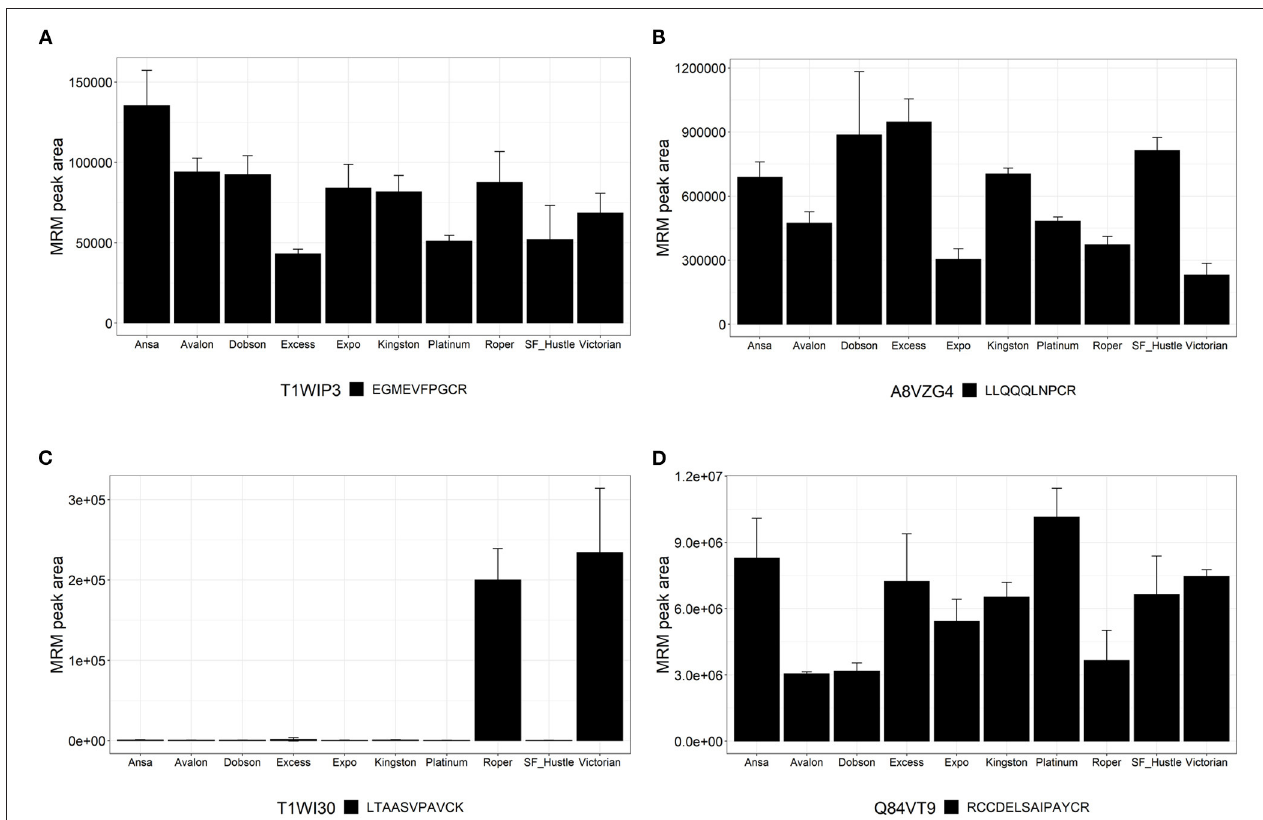
FIGURE 5 | Relative quantitation of peptides across the 10 varieties of L. perenne from proteins of the Pfam family PF00234. Graphs show the MRM peak area for each cultivar. Data are presented as the mean ± SD ( n = 3) with one peptide from each protein. (A) Dimeric alpha-amylase inhibitor (T1WIP3); (B) Alpha-gliadin (A8VZG4); (C) Dimeric alpha-amylase inhibitor (T1WI30); and (D) Trypsin inhibitor